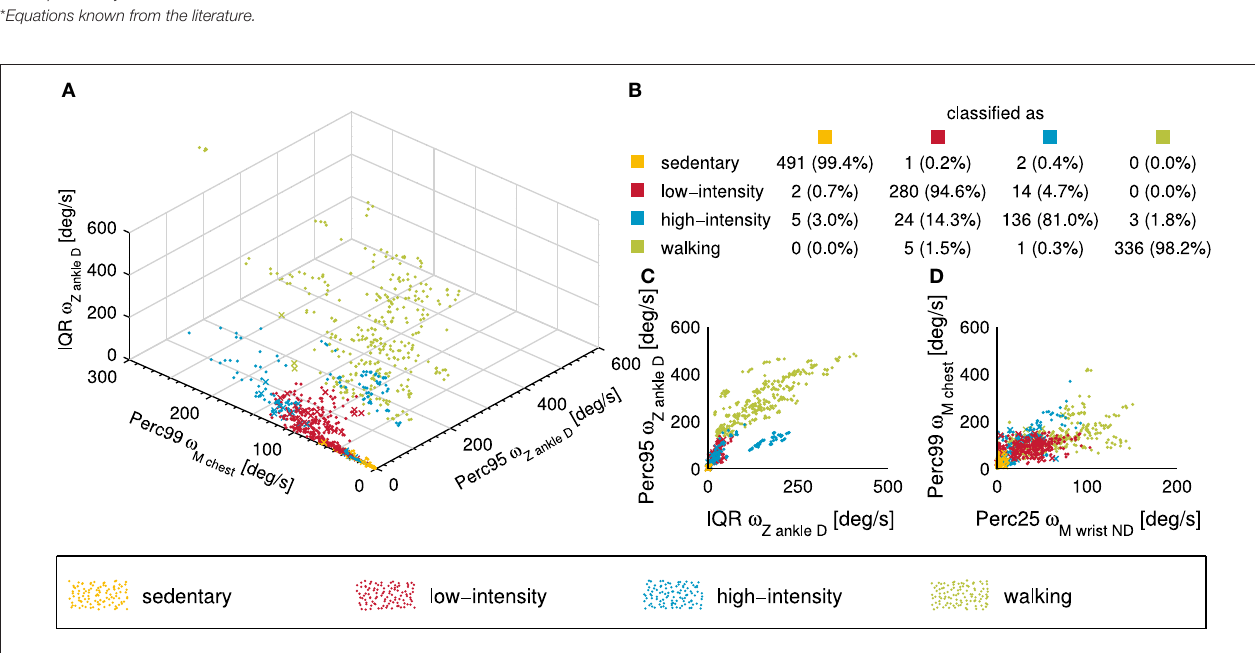
FIGURE 3 | Visual presentation of the classification performance of the k-nearest neighbor (kNN) classifier used in this study. (A) 3D scatter plot showing the different activity classes for the three features explaining most of the variance. Note that a point corresponds to a correctly classified activity while a cross represents an incorrectly classified activity. (B) Confusion matrix of the entire data set ( n = 1,300) is presented in this subplot. The overall classification accuracy of the kNN classifier was 95.6%. (C,D) Two 2D scatter plot showing the different activity classes from a different point of